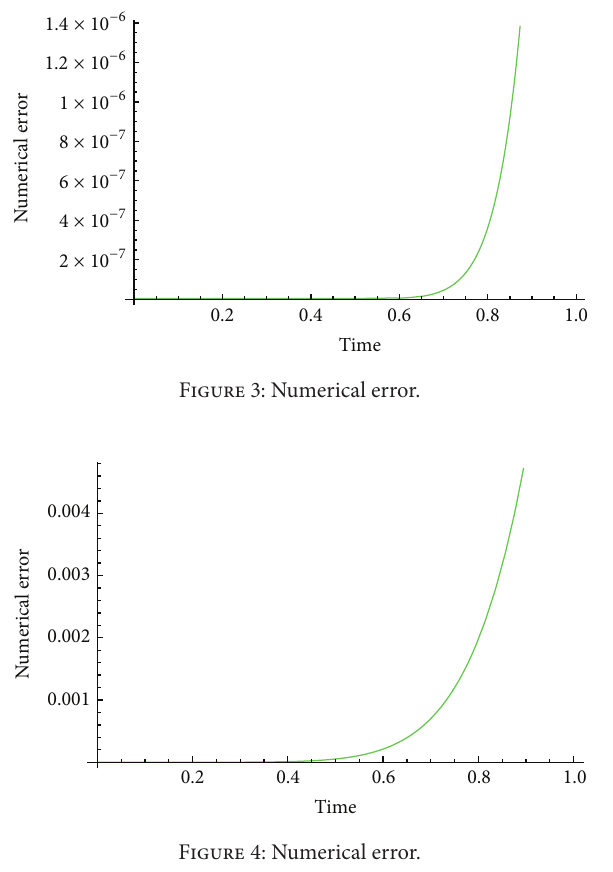
Figure 4: Numerical